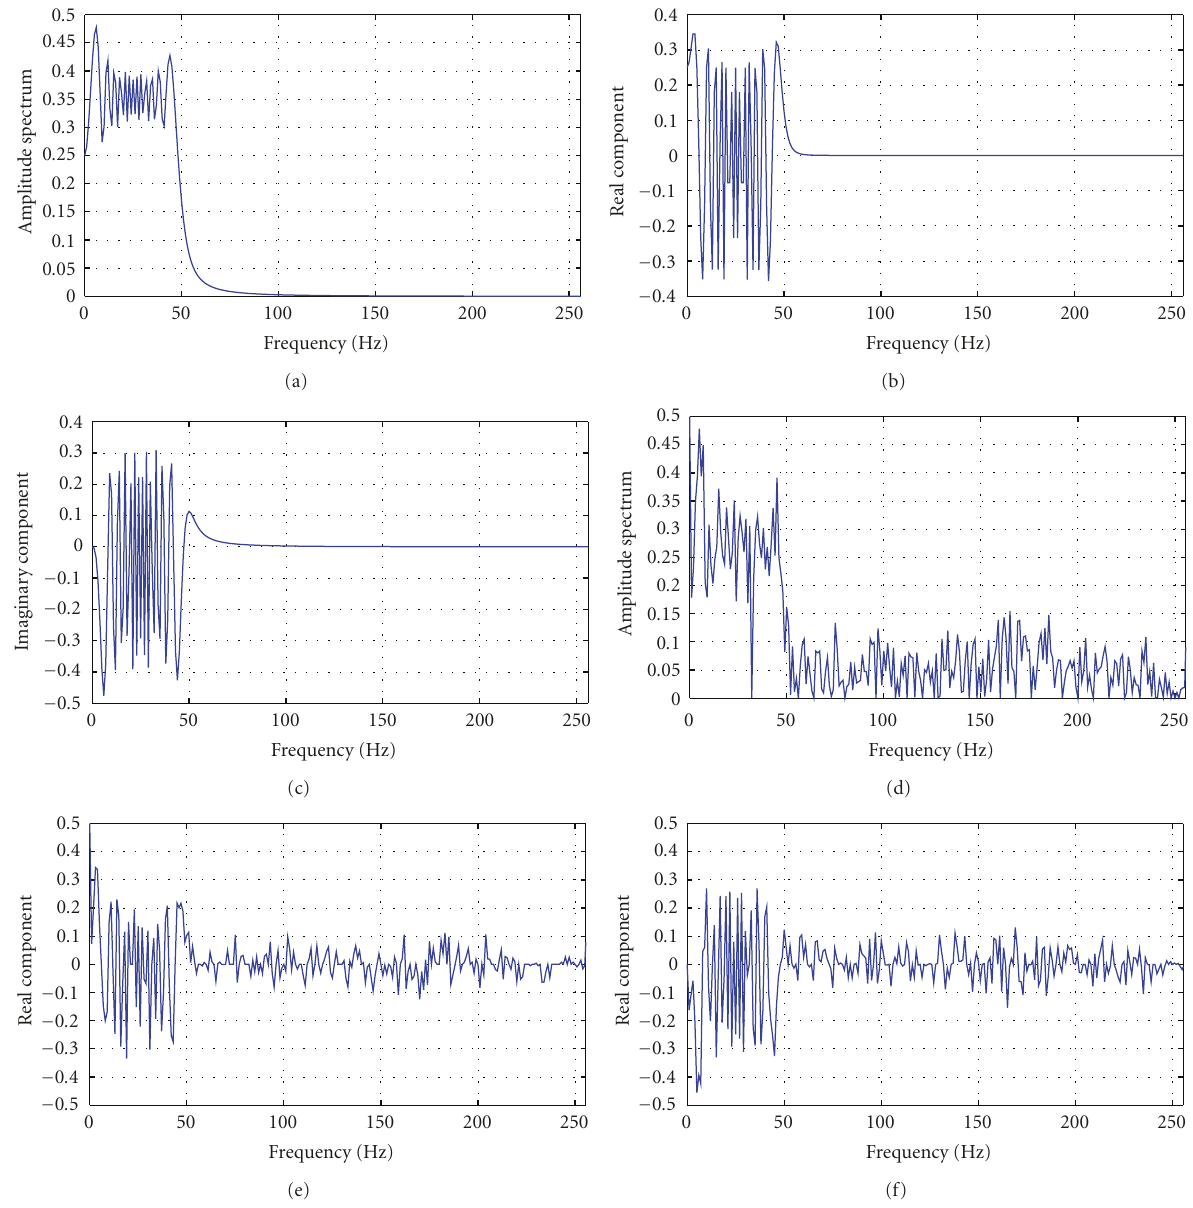
Figure 7: Amplitude spectrum of noise-free FM signal s 2 ( n ) (left column), and its RE (central column) and IM (right column) components obtained by standard DFT ((a)–(c)) and MED-form of RDFT ((d)–(f)).